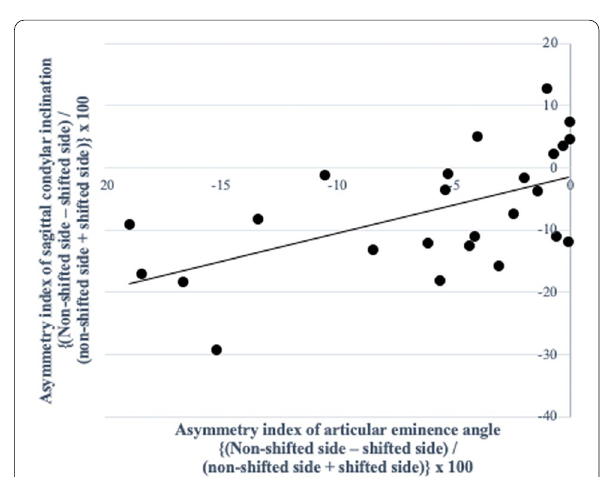
Fig. 8 Simple regression analysis of the asymmetry index of the articular eminence angle and the sagittal condylar inclination in the mandibular asymmetry group. X ‑axis, asymmetry index of the articular eminence angle; Y ‑axis, asymmetry index of the sagittal condylar